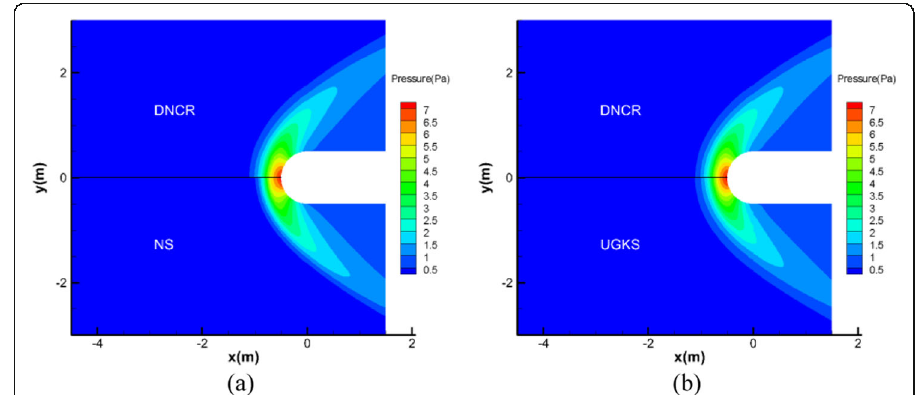
Fig. 8 Pressure contours of DNCR, UGKS and NS solutions